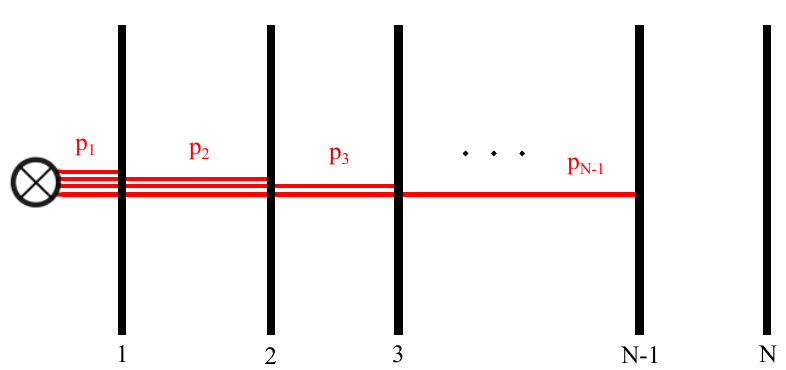
Figure 11 . In this (cid:12)gure we show how to construct the string theory embedding of a SU( N ) irreducible ’t Hooft operator of charge P = P